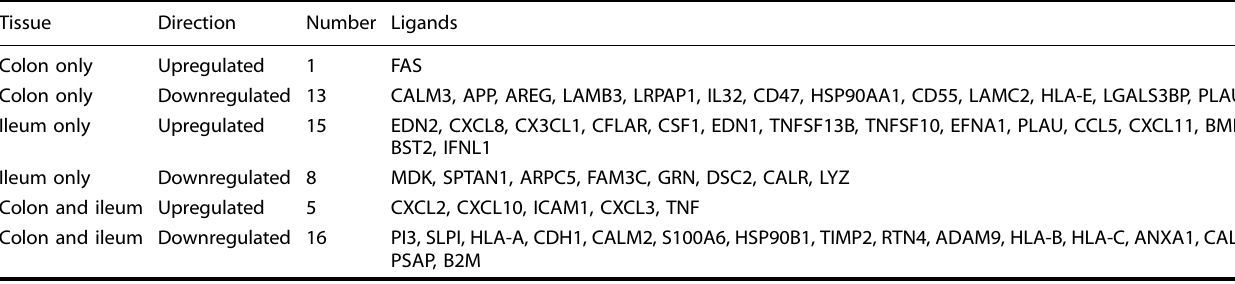
Table listing the number of ligands of infected immature enterocytes – immune cells intercellular network that are unique or shared between the ileum and colon.